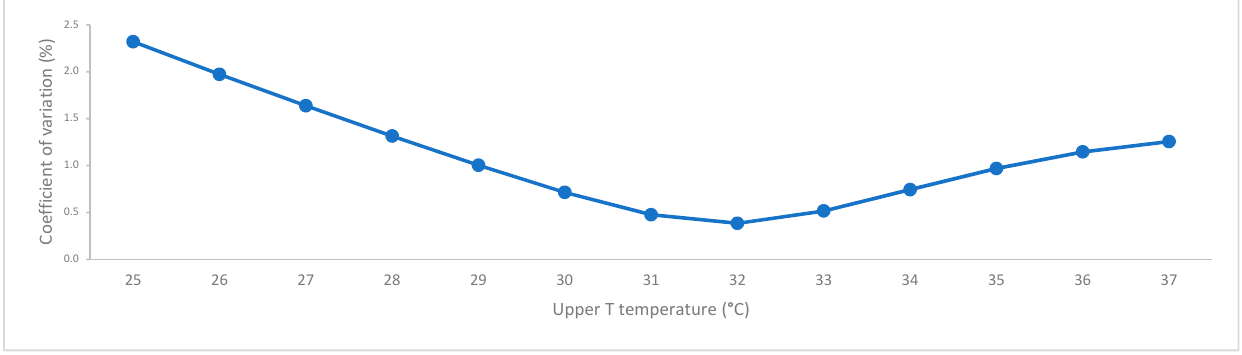
Figure 3. Coefficient of variation for GDD calculated using different upper base temperatures (TB) and a Tb of 12°C. Data of three flowering events of the northern-most farms of this study, in Darwin and Katherine, NT (Table A1).